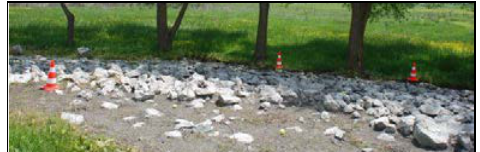
Figure 15. Traffic cones and tennis balls used for point cloud